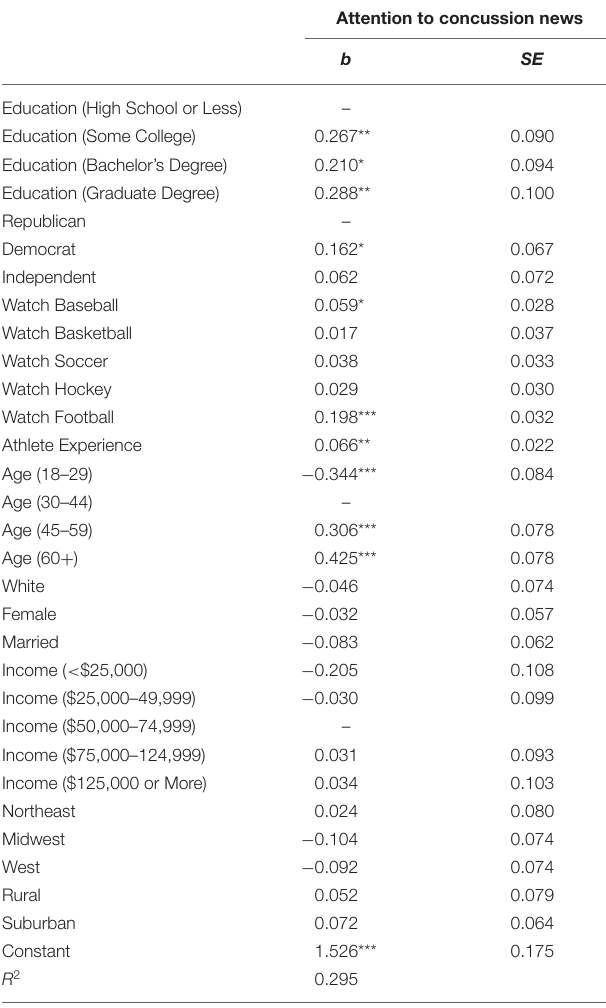
TABLE 2 | Regression model predicting attention paid to news of concussions in sports